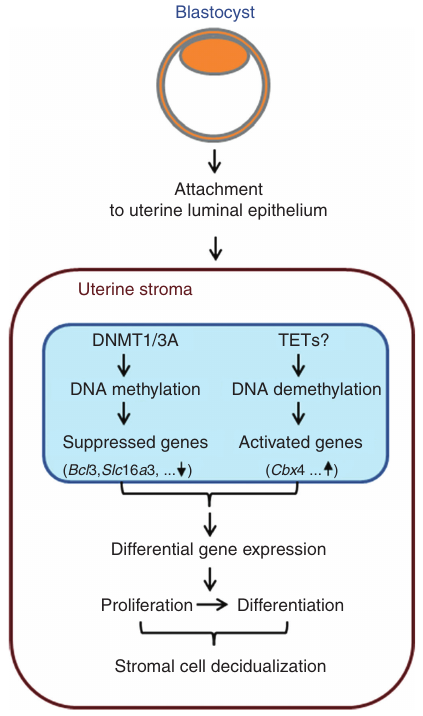
Figure 4 A proposed model for stromal cell decidualization at the site of implantation via DNA methylation/demethylation for differ- ential gene